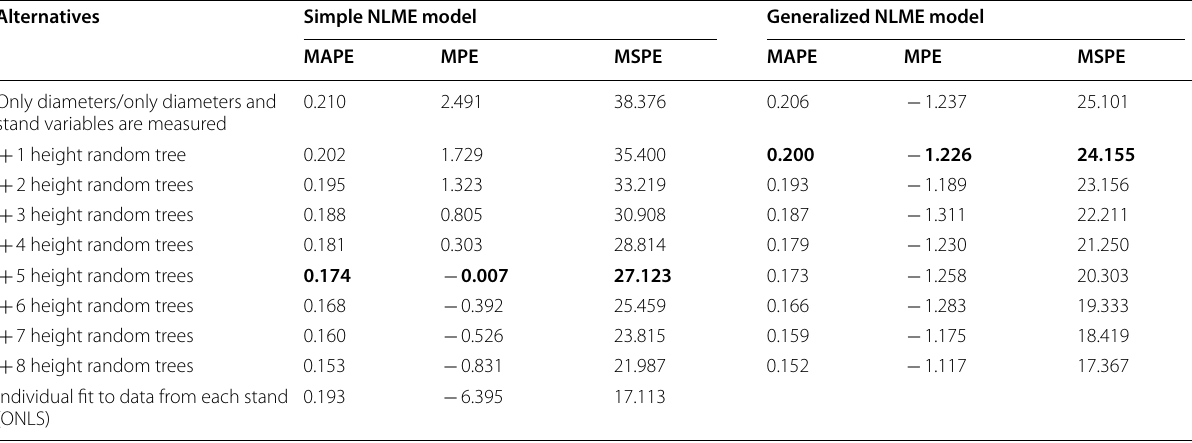
Only diameters/only diameters and stand variables are